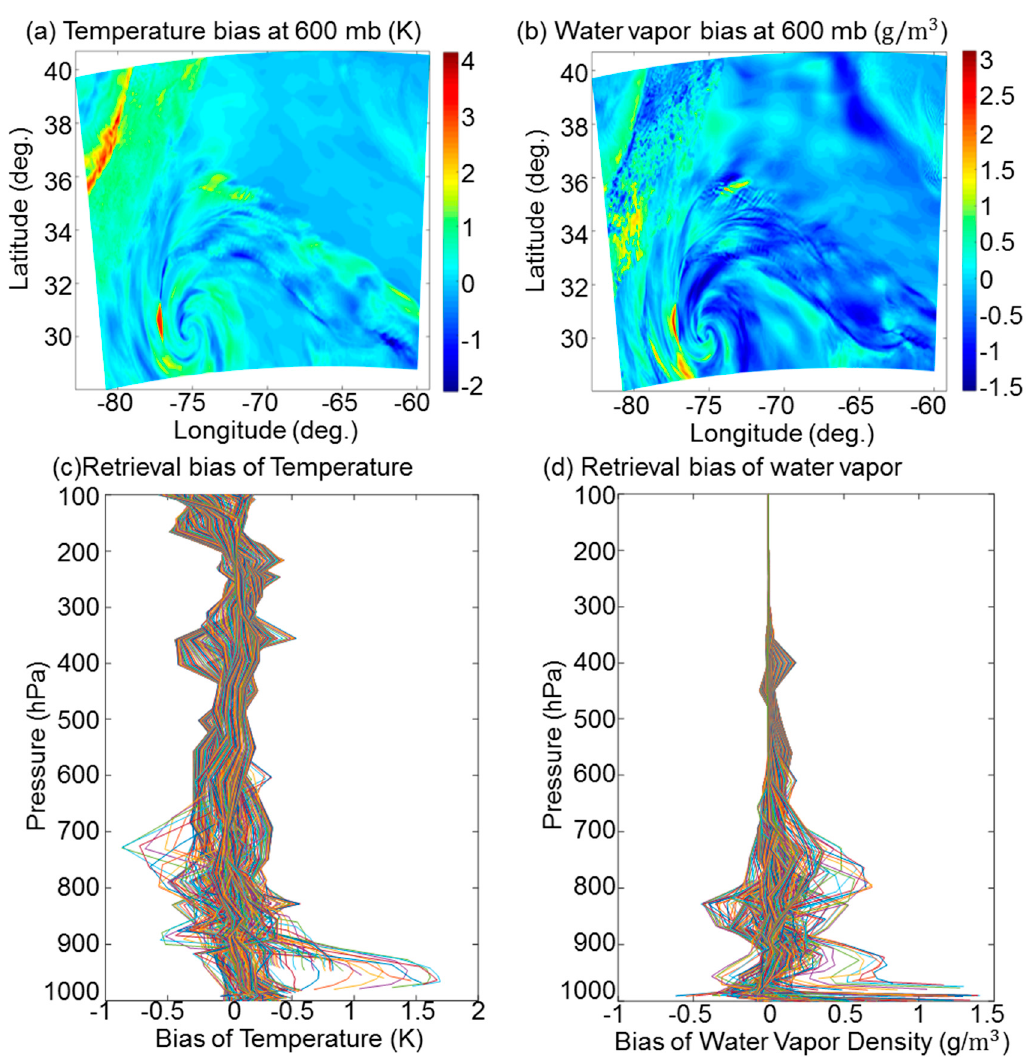
Figure 10. Temperature and water vapor density retrieval biases using combined NN and 1DVar algorithm: (a) temperature bias at 600 mb; (b) water vapor density bias at 600 mb; (c) temperature bias at different pressure levels; (d) water vapor density bias at different pressure levels.